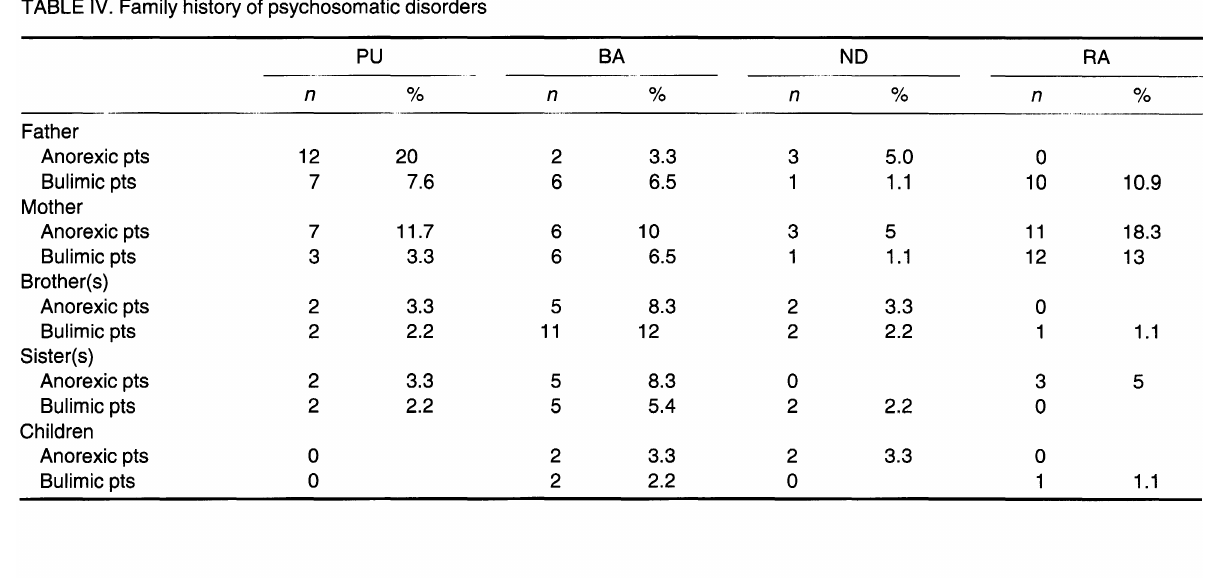
TABLE IV. Family history of psychosomatic